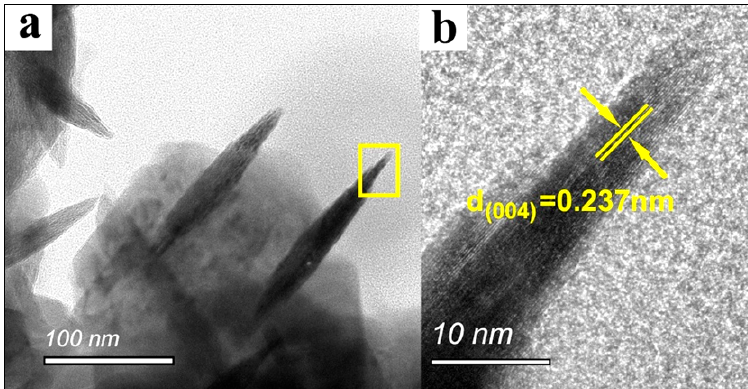
Figure 3. ( a ) TEM image of the of the anatase sheets; ( b ) high-resolution TEM image of the edge of a single anatase sheet selected in the rectangle region in ( a ).